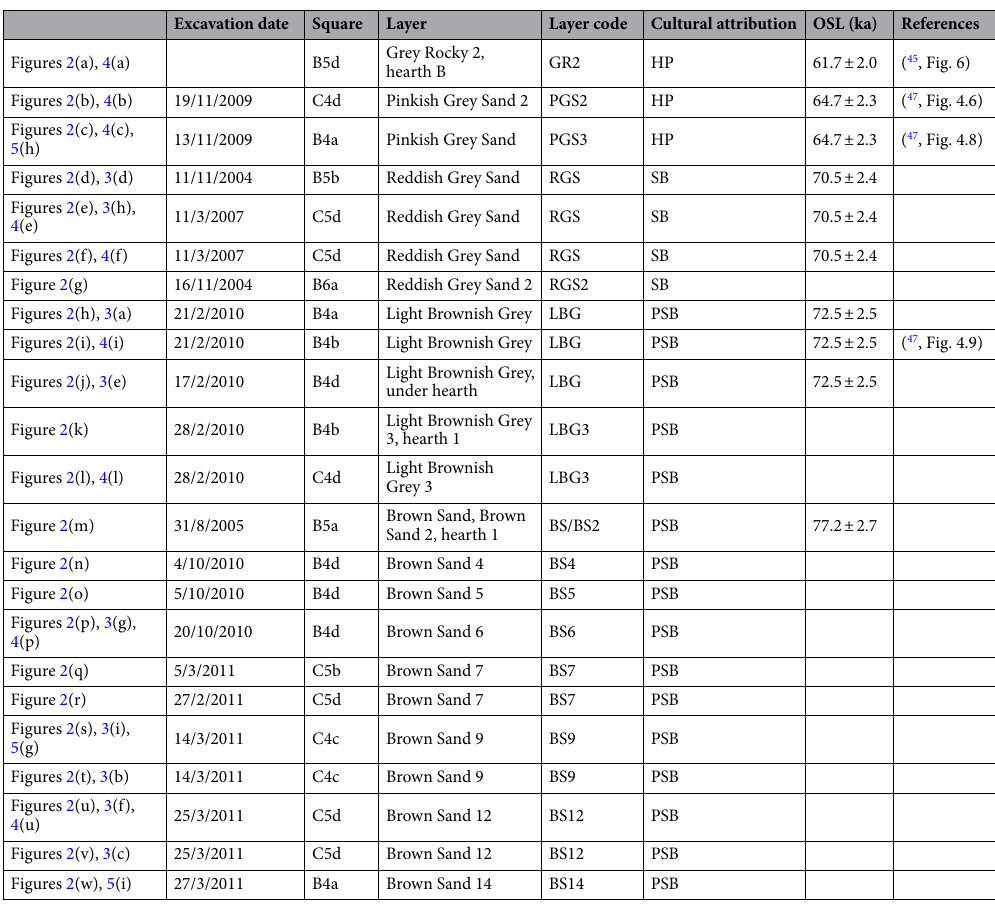
Table 1. Contextual data on the double-beveled bone tools from Sibudu. Excavation date, stratigraphic provenance, and cultural attribution of the bone tools reported in the present study. OSL ages (in ka) were reported in 49,55 . Four tools were described in previous publications but were not submitted to texture